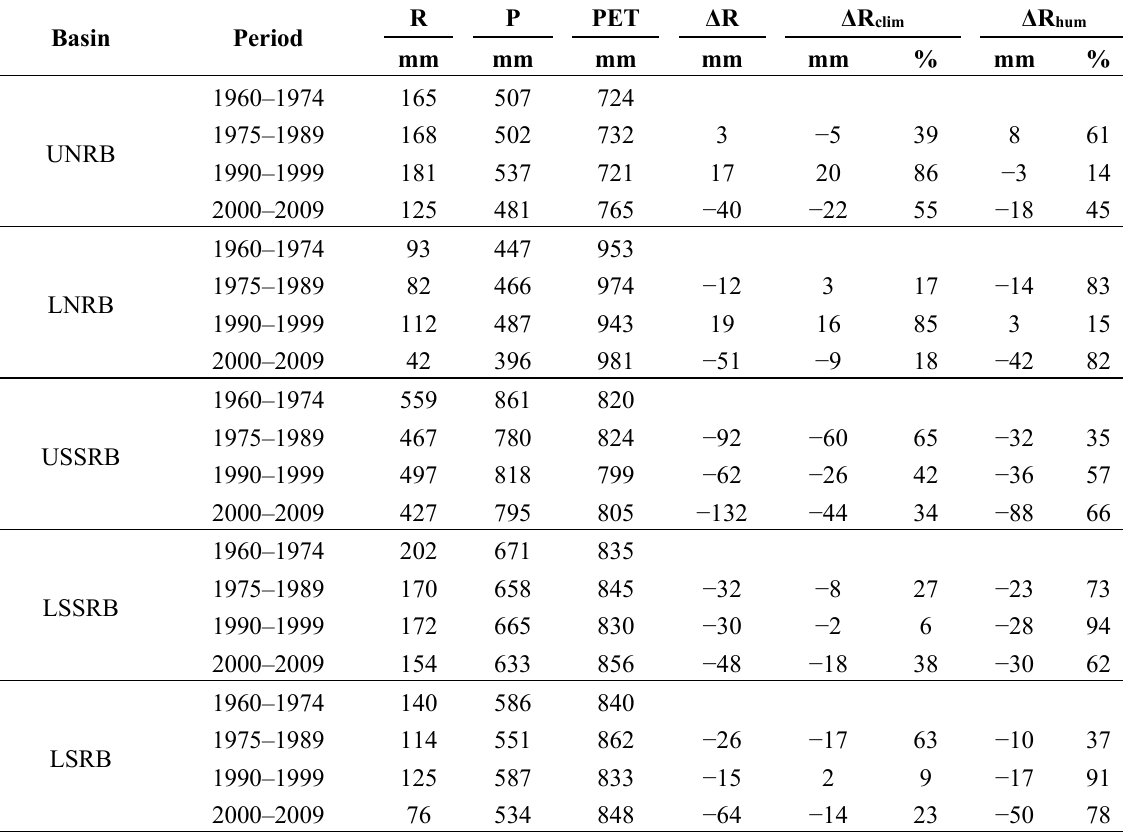
Table 5. Contributions of climate variation and human activities on changes in runoff in the Upper Nenjiang River Basin (UNRB), Lower Nenjiang River Basin (LNRB), Upper Second Songhua River Basin (USSRB), Lower Second Songhua River Basin (LSSRB), and Lower Songhua River Basin (LSRB) in Northeast